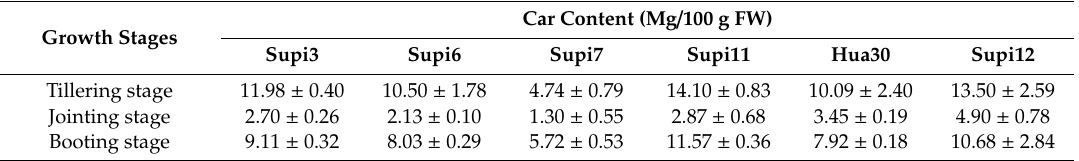
The carotenoid (Car) content (mean ± SD) in the six barley cultivars at di ff erent developmental